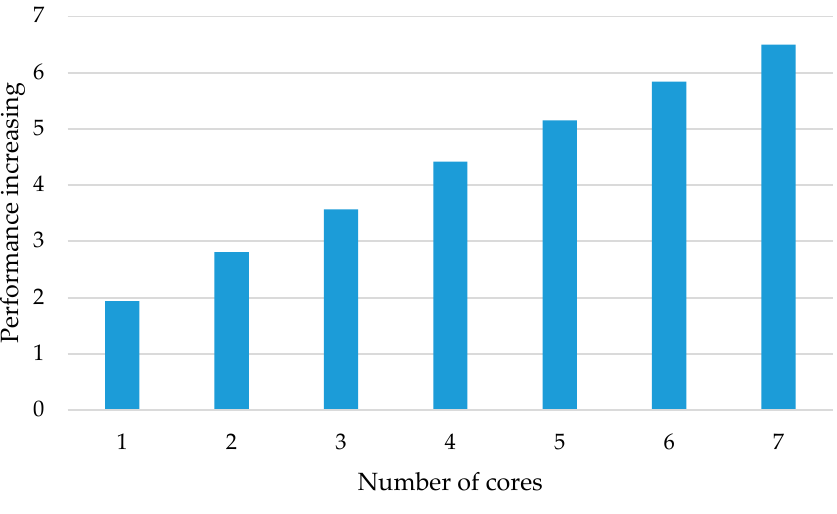
Figure 4. The parallelization effect.